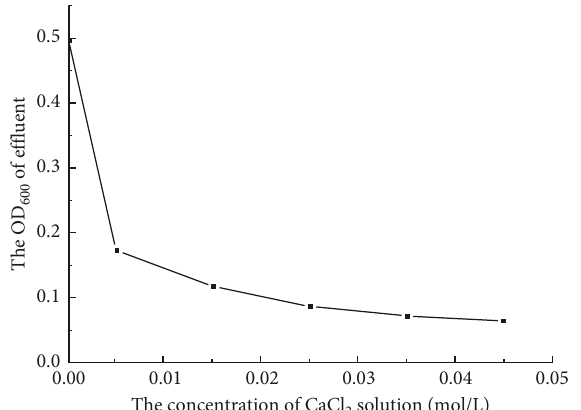
Figure 10: Curve of the OD 600 value of effluent with the con- centration of CaCl 2 solution.